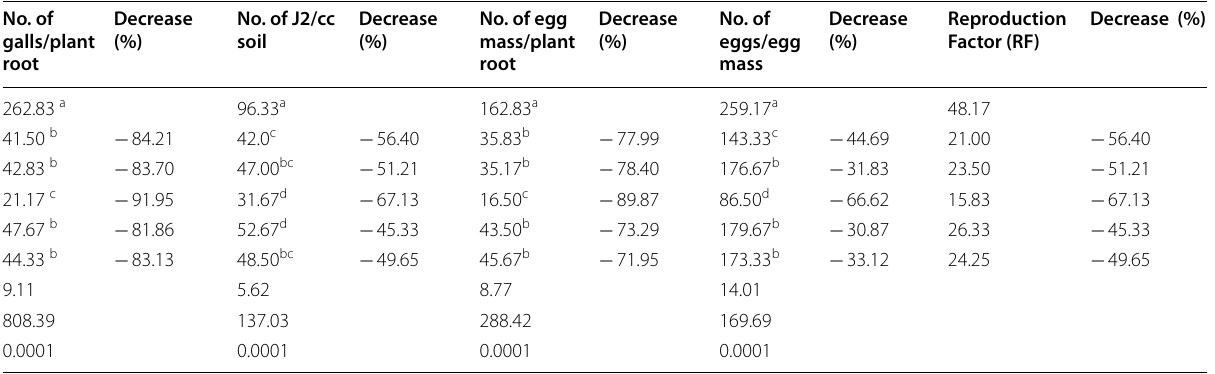
Means with the same letter are not significantly different B. p, Bacillus pumilus , B. m, Bacillus megaterium , B. s, Bacillussubtilis , B. c, Bacillus cereus , Mi, Meloidogyne incognita , VP, Velum prime (Nematicide)